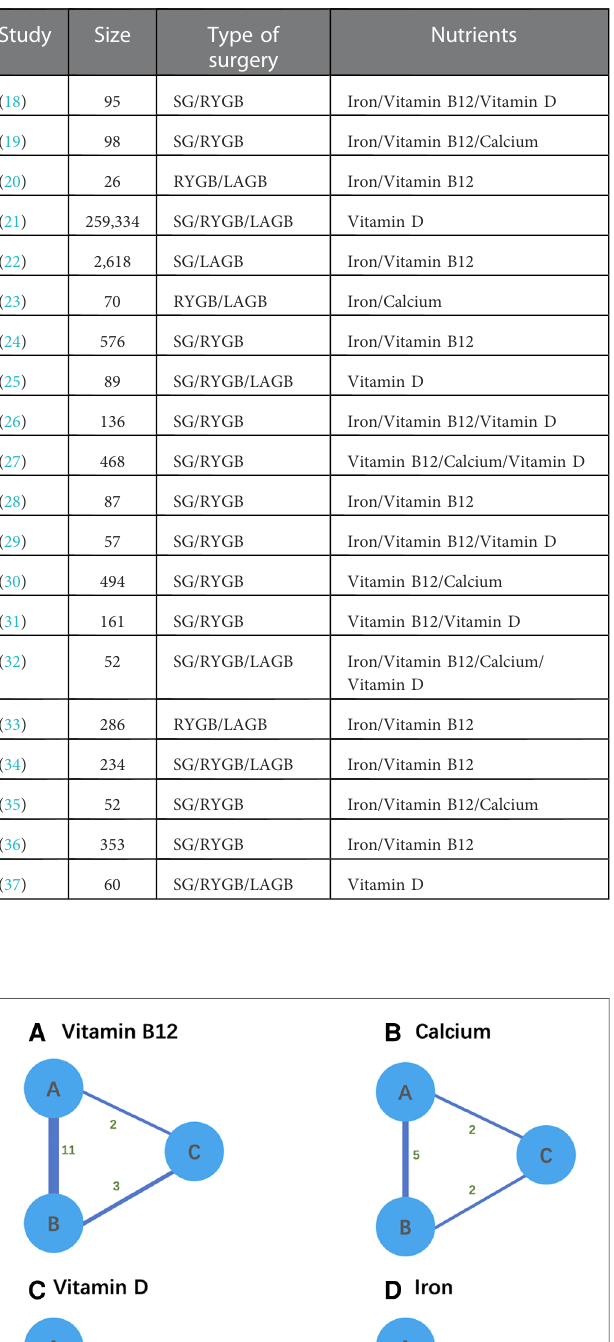
TABLE 1 Main characteristics of included studies.